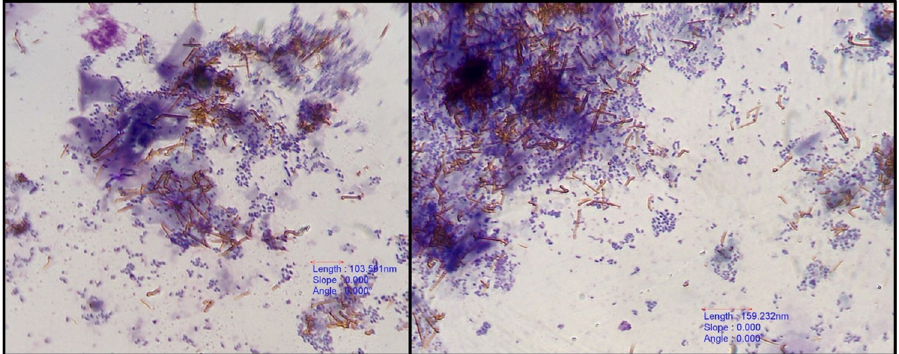
Fig 2. Bacteria mixed with golden-brown bile pigment. 40x. Diff-Quik stain, euromex CMEX 5 microscope